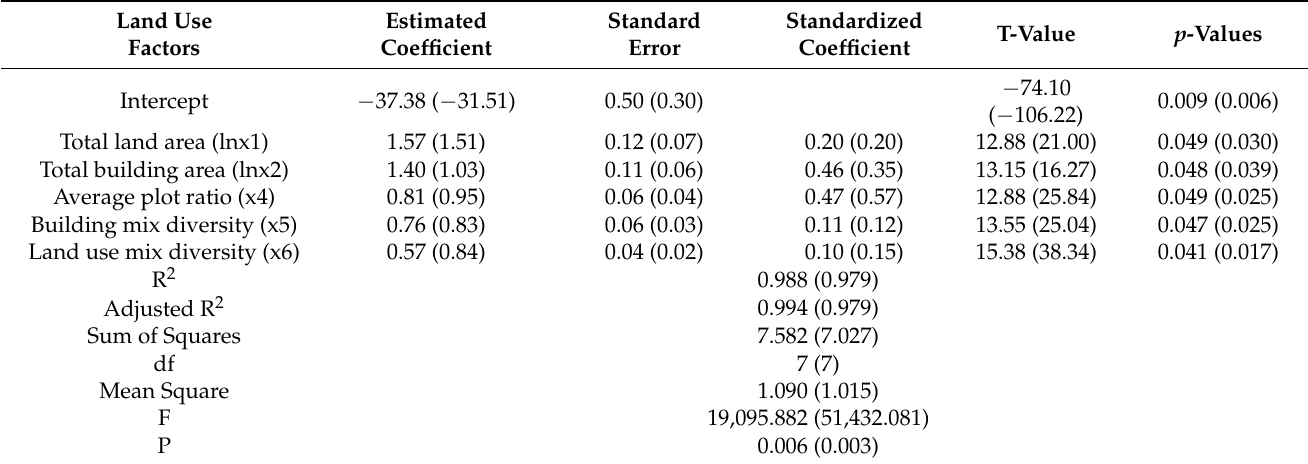
Table 2. Stepwise multiple linear regression of station inbound and outbound